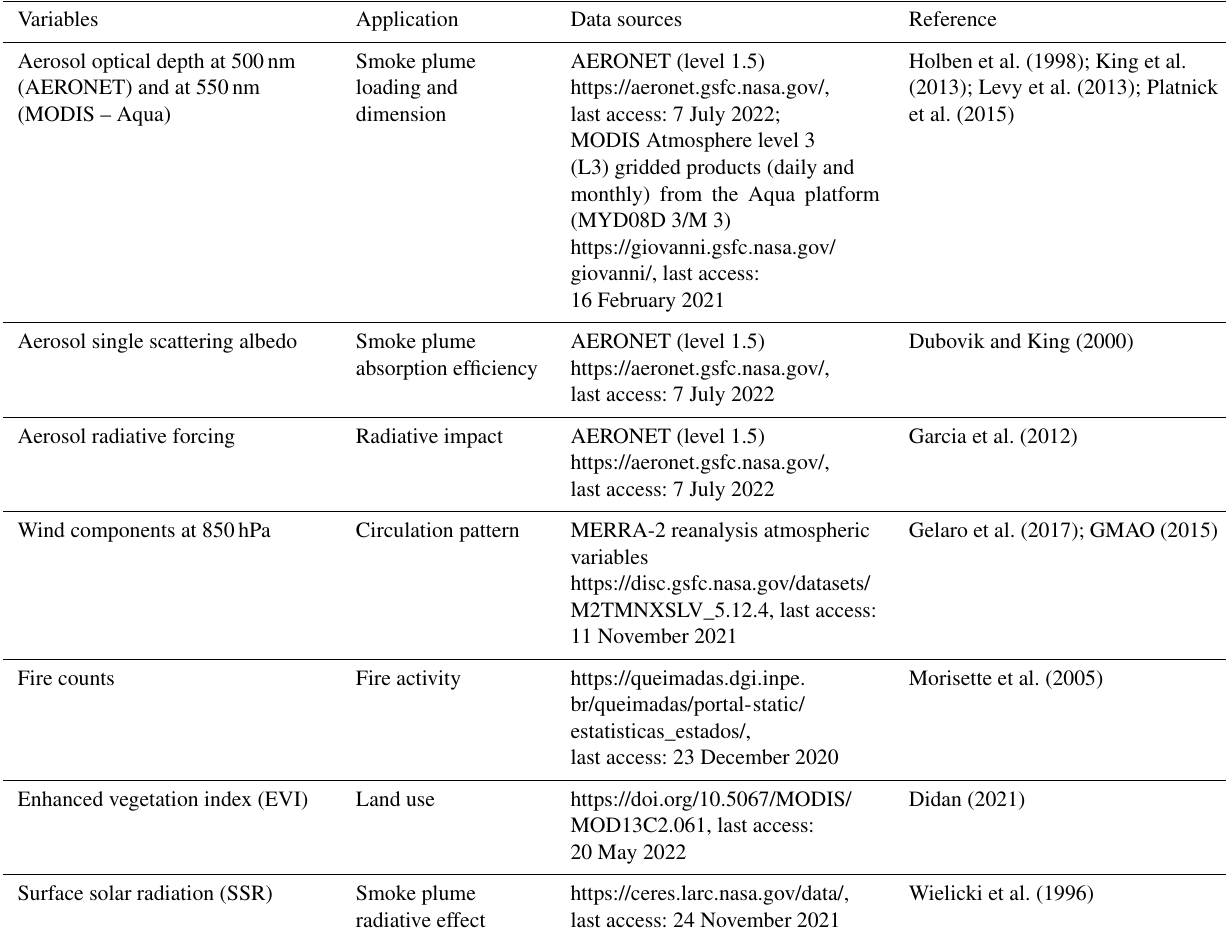
Table 1. Set of variables used in this study, their respective applications, sources, and